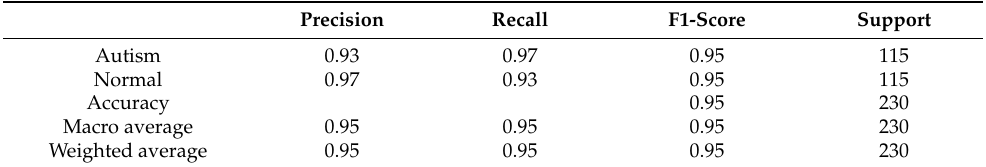
Table 6. Classification report for the method in Section 2.2.2 and Table A1 (reproduced from screen-